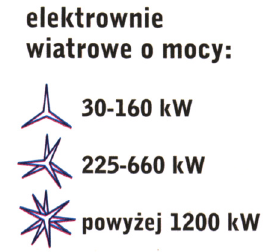
Fig. 5. “Quantitative signature symbols” used to demonstrate the wind power plants